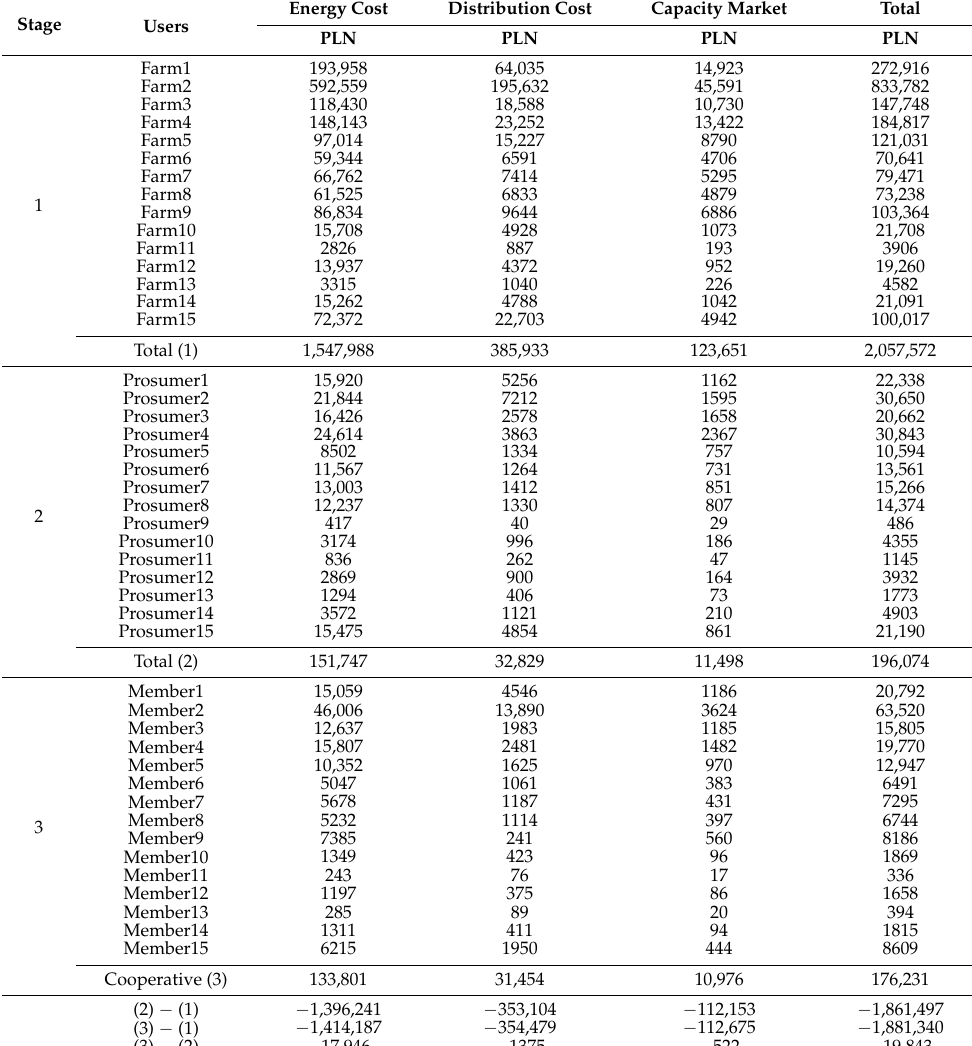
Table 5. Economic account results for energy cooperative